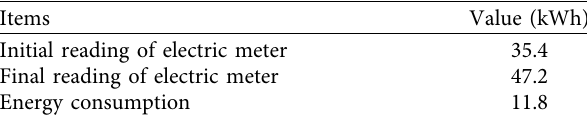
Table 6: Reads of the electric